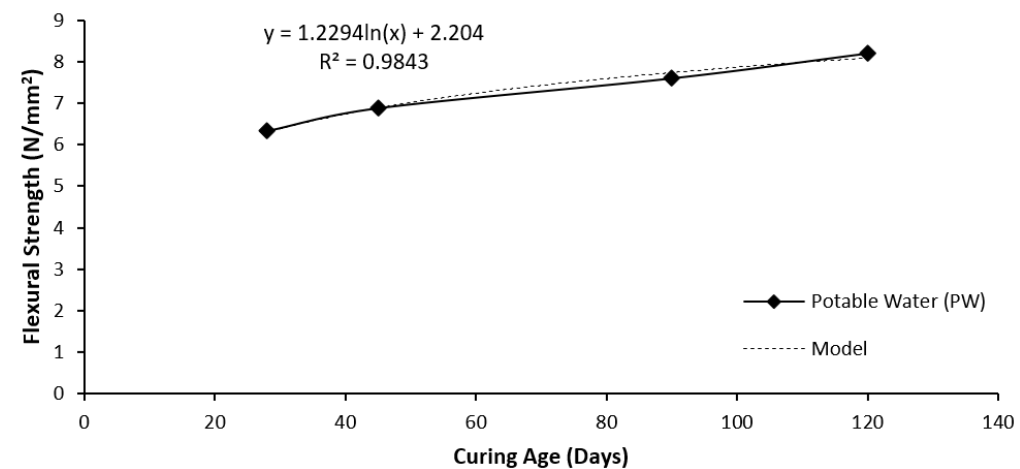
Figure 8. Flexural strength of concrete cured in potable